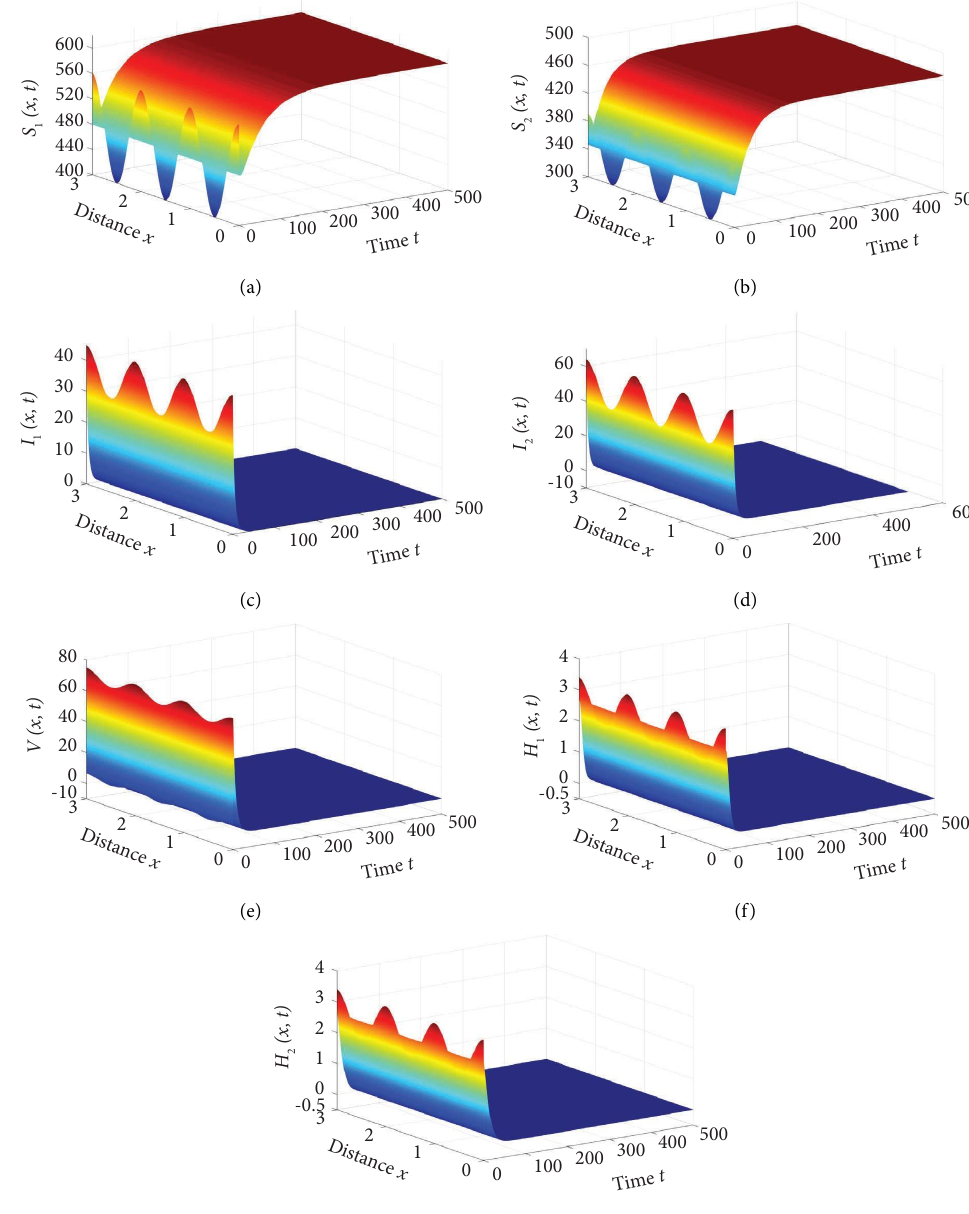
� ( 600 , 466 . 6667 , 0 , 0 , 0 , 0 , 0 ) is ≤ 1, and the steady state Π 0 0